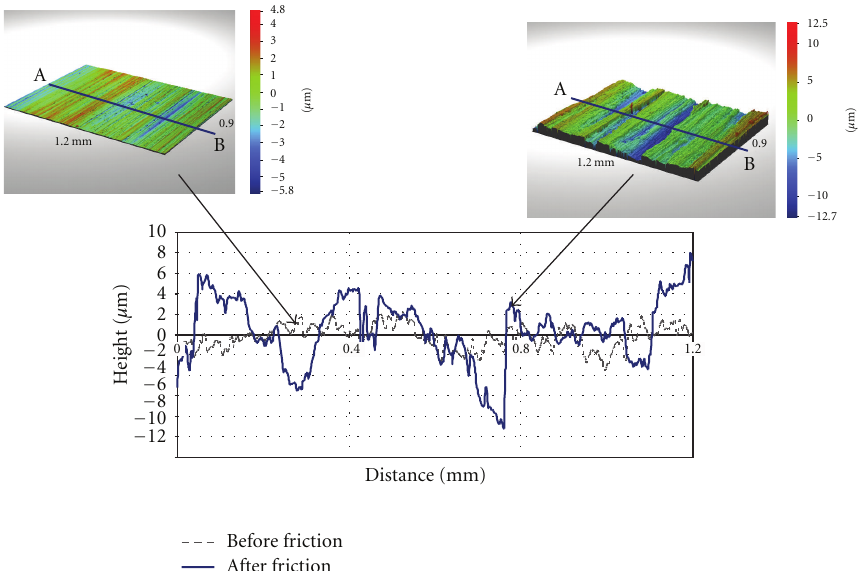
Figure 8: Surface topographies for conditions V = 20m / s and P a = 40MPa and superposition of the 2D profiles (along the line AB).